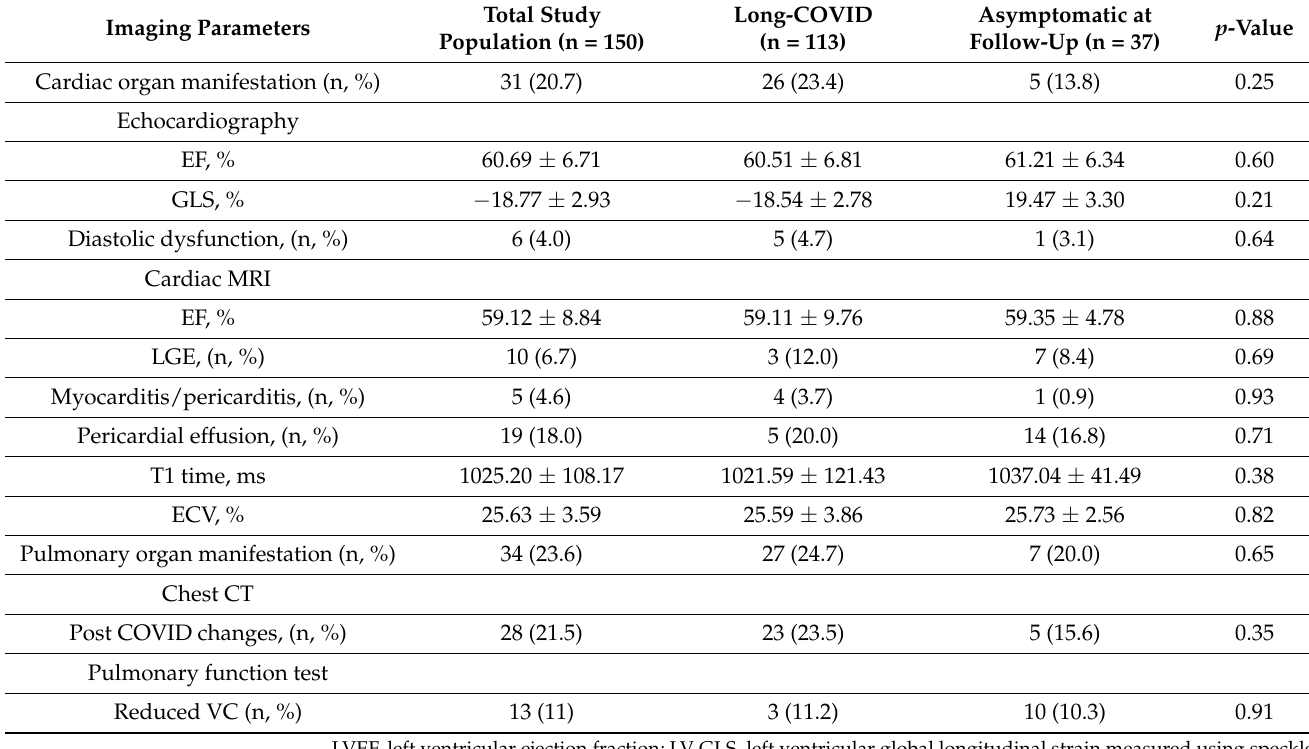
Table 2. Imaging parameters of the 150 study participants 6 months post COVID-19